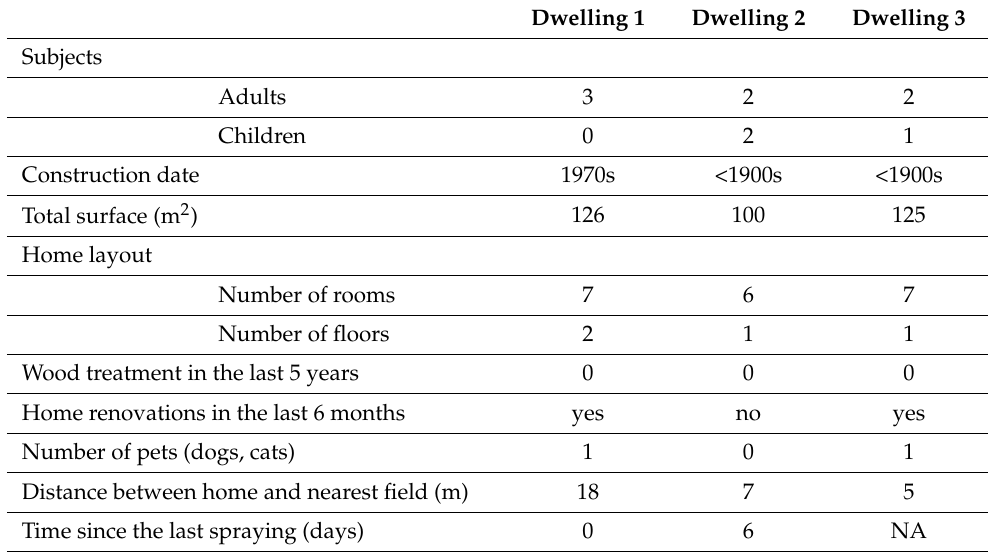
Table 2. Characteristics of the households included in the PESTIPREV 1